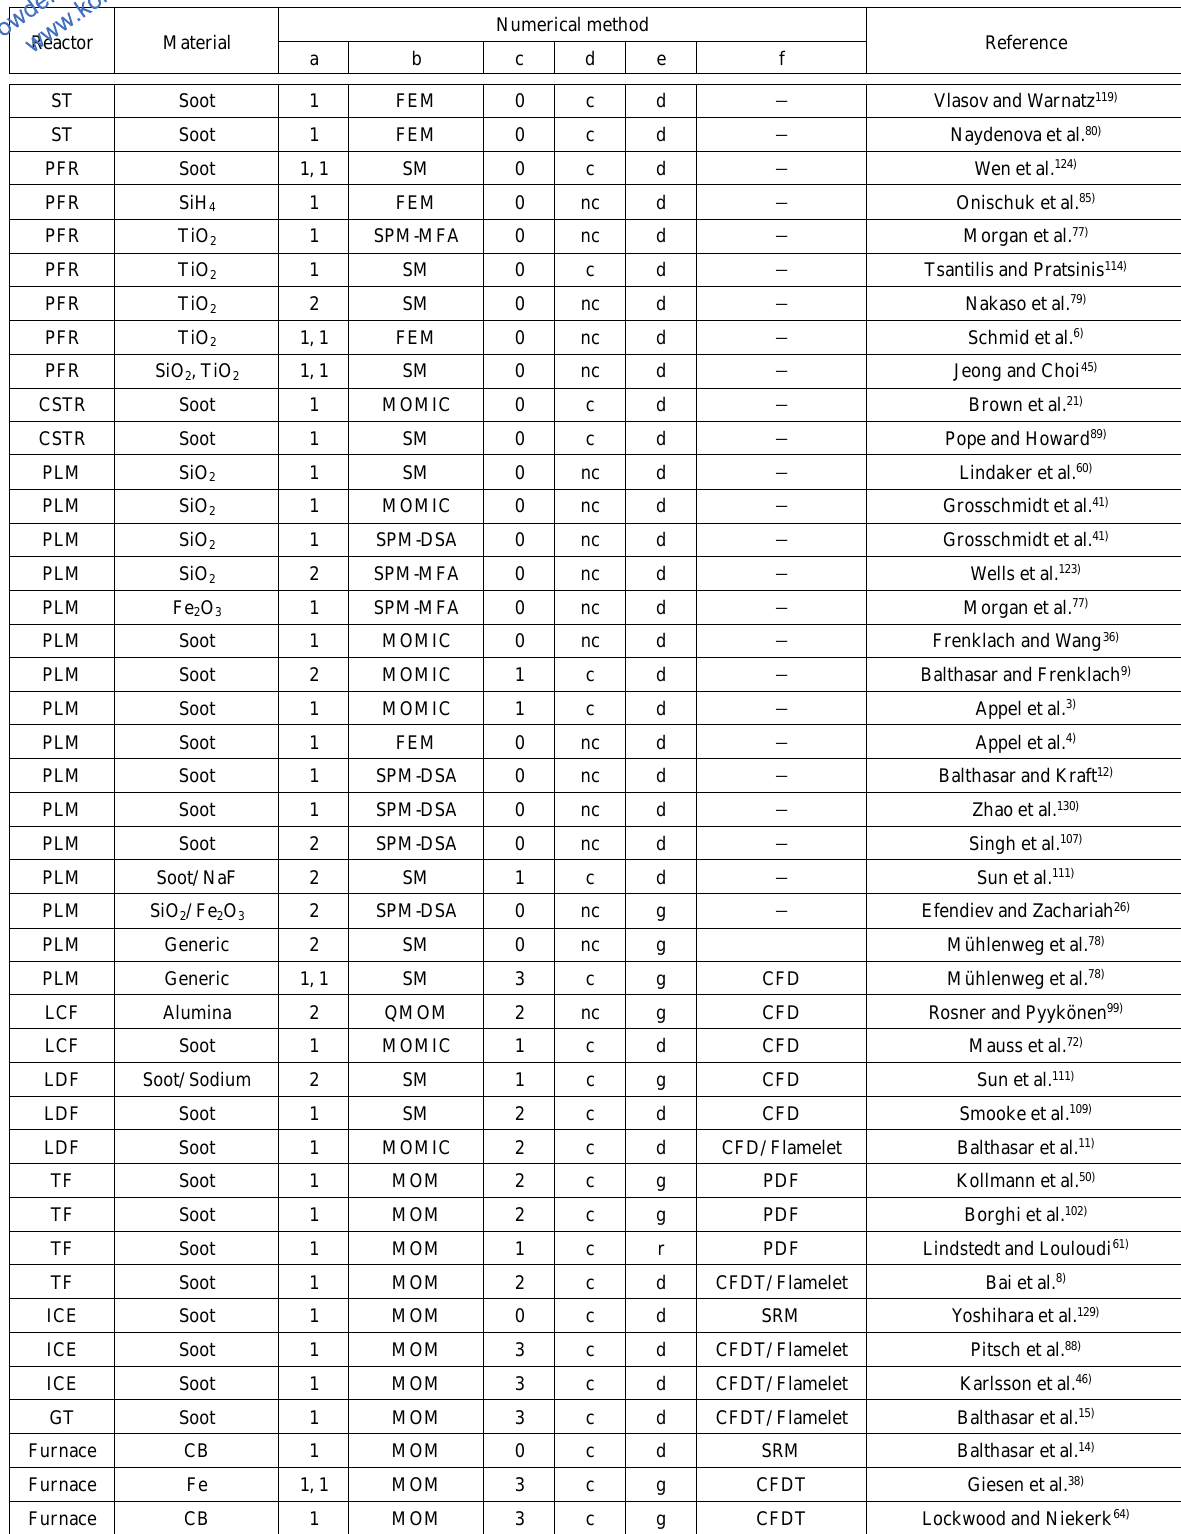
Table 1 List of